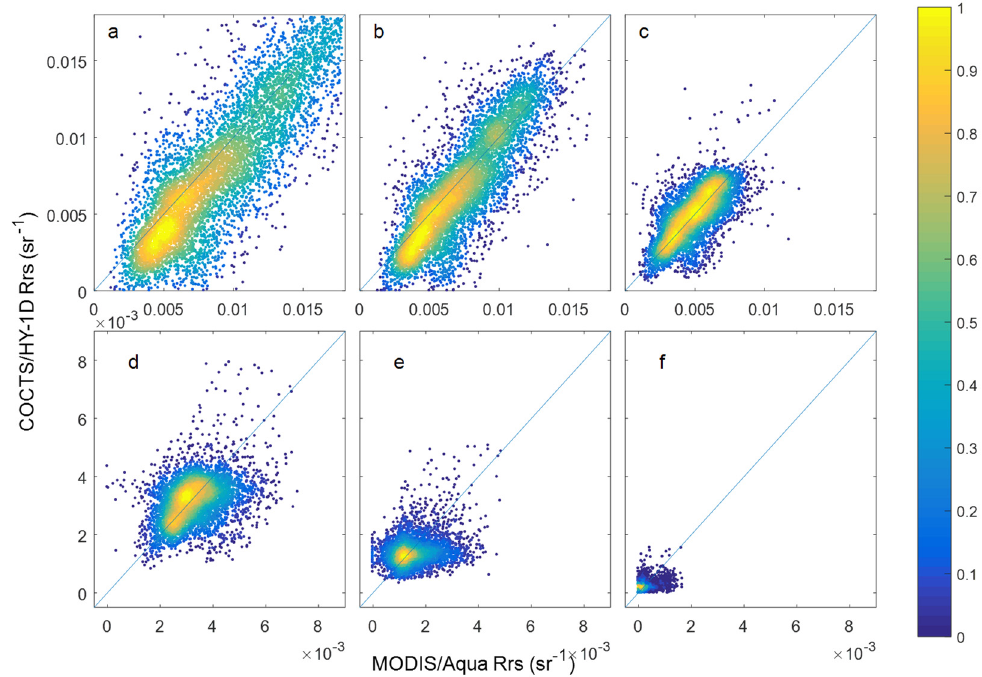
Figure 7. Evaluation of the consistency of the daily global R rs imagery between C CTS/HY-1D and MODIS/Aqua on 2 October 2020 at six bands ( a – f ). Table 5. The evaluation of the R rs of COCTS/HY-1D on 2 October 2020, using those of Aqua as the truth